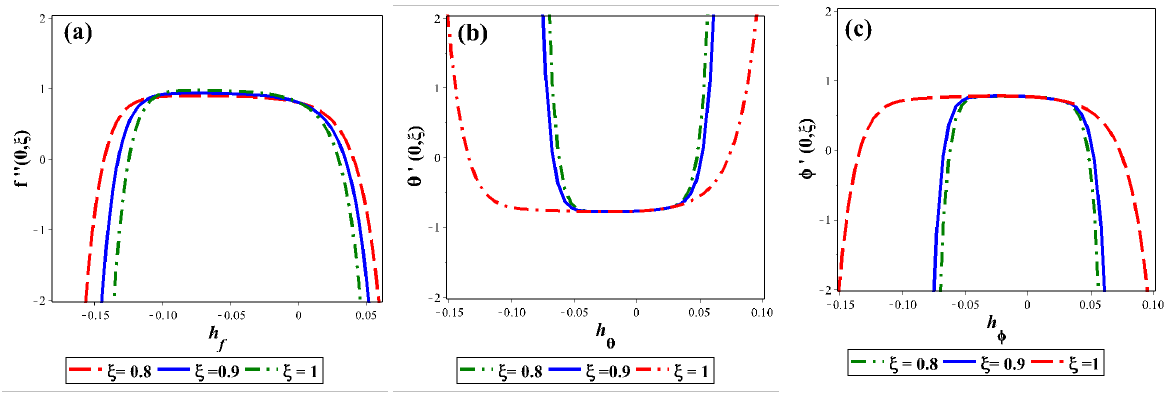
Fig. 2: Validation of h-values of f (cid:48)(cid:48) (0), θ (cid:48) (0)and ϕ (cid:48) (0) for different values of ξ (order = 10).